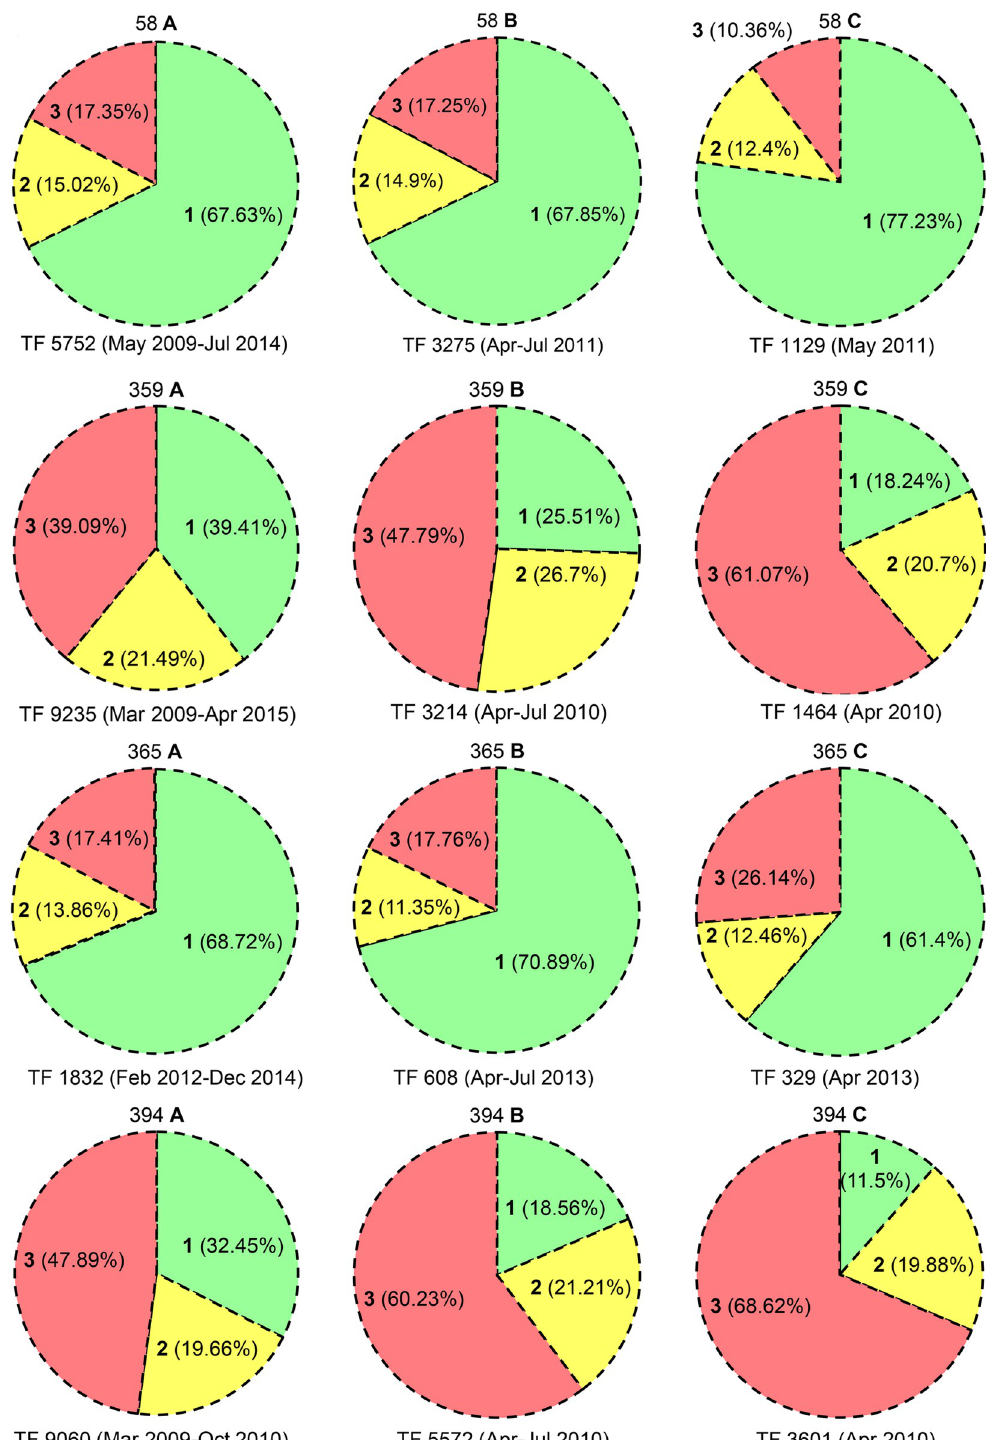
Fig 6. High reward, high predation. M . baccifera clumps: 58, 359, 365, 394; A. TF— Total fruits ; 1 , % GF ( Good fruits ), 2 , % IF ( Immature fruits ), 3 , % PF ( Predated fruits ) in the full flowering period of the clump; B. TF— Total fruits ; 1 , % GF, 2 , % IF, 3 , % PF in April-July of the year in which the clump recorded highest fruit production in a single month; C. TF— Total fruits ; 1 , % GF, 2 , % IF, 3 , % PF in a single month of highest fruit production.